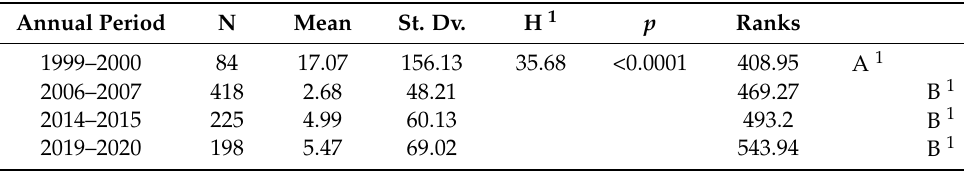
Table A3. Area’s Kruskal Wallis tests between time periods.